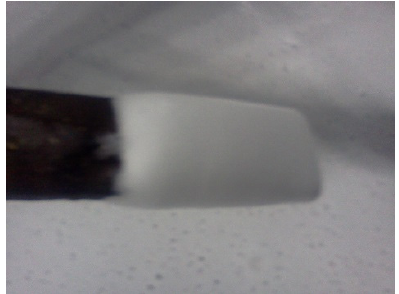
Figure 8. Shape of the discharging compressed air foam of specimen III.